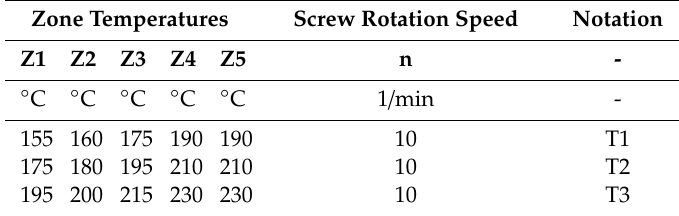
Table 1. Processing parameters of polylactic acid (PLA)-based foams via extrusion.